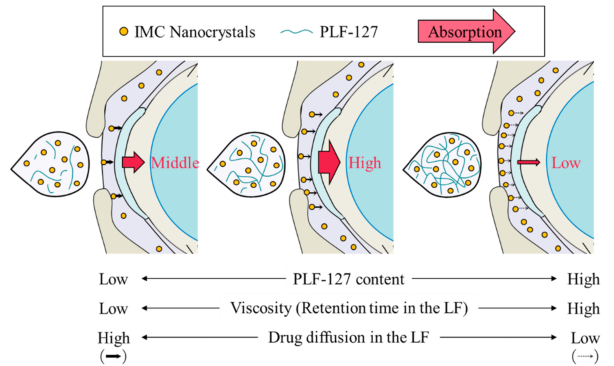
Figure 7. E ff ect of PLF-127 content on corneal permeability in IMC-NC-incorporating